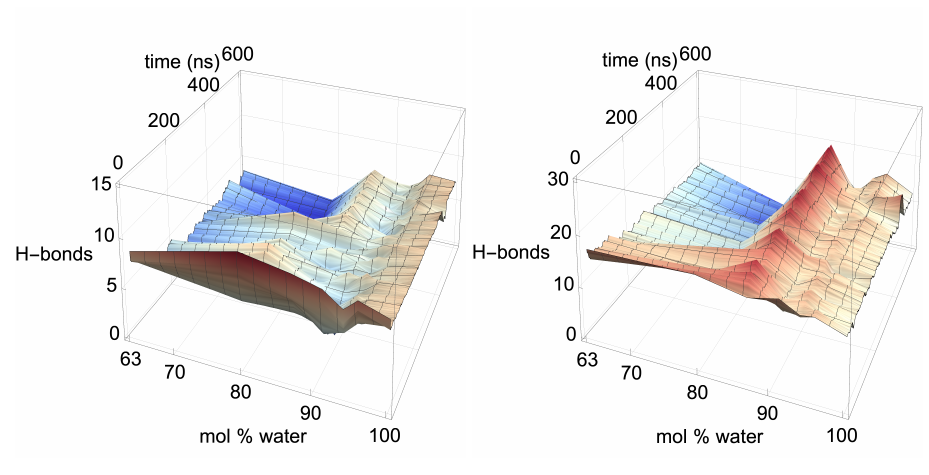
Figure A13. The hydrogen bonding for the second yellow separating strand at 360K (Part 2 of 2). The hydrogen bonds are shown between the following: ( a ) cellulose: intra–peeling strand (i.e., the intra-strand hydrogen bonds for the separating strand); ( b ) cellulose: inter–peeling strand (i.e., the inter-strand hydrogen bonds for the separating strand). These data represent the second yellow strand to peel or the non-peeling yellow strand if the second yellow strand does not peel in the simulation. The data were averaged over 1000 data points, using a rolling average. Every 100th point was then plotted to maintain plot clarity